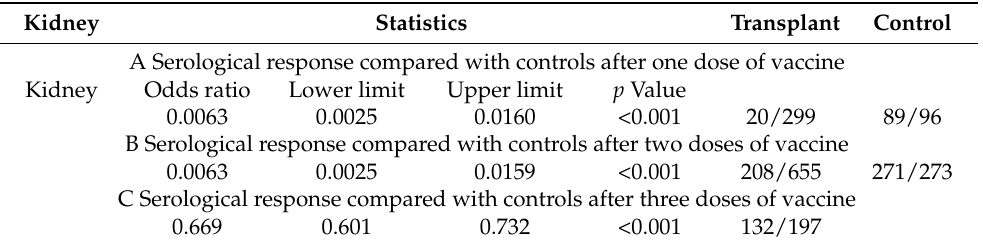
Table 3. Serological response after different vaccine doses in KTx recipients according to the studies of Sakuraba et al., Massa et al. and Masset et al. [50–52]. Kidney Statistics Transplant Control Kidney Statistics A Serological response compared with controls after one dose of vaccine Kidney Odds ratio Lower limit Upper limit p Value 0.0063 0.0025 0.0160 <0.001 20/299 89/96 B Serological response compared with controls after two doses of vaccine 0.0063 0.0025 0.0159 <0.001 208/655 271/273 C Serological response compared with controls after three doses of vaccine 0.669